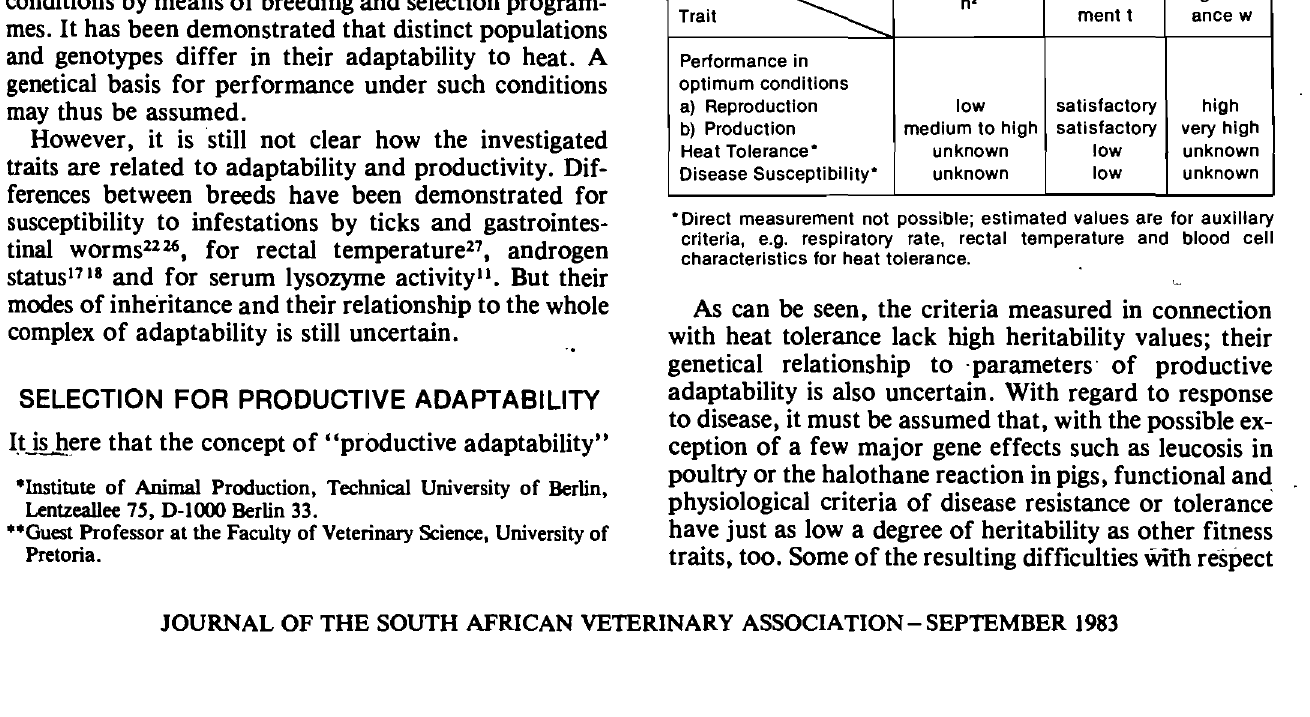
Table 1: SUITABILITY OF TRAITS FOR SELECTION